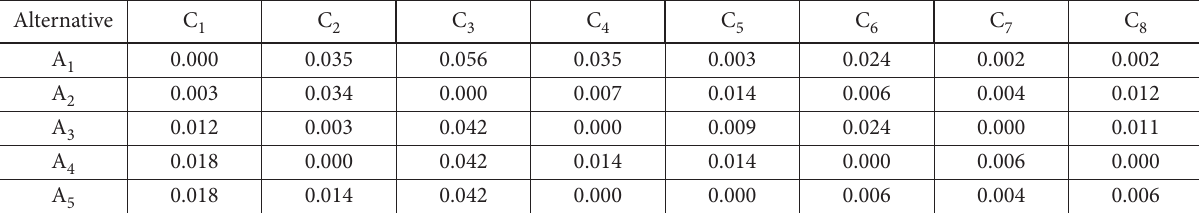
Table 10. The real evaluation matrix for Scenario